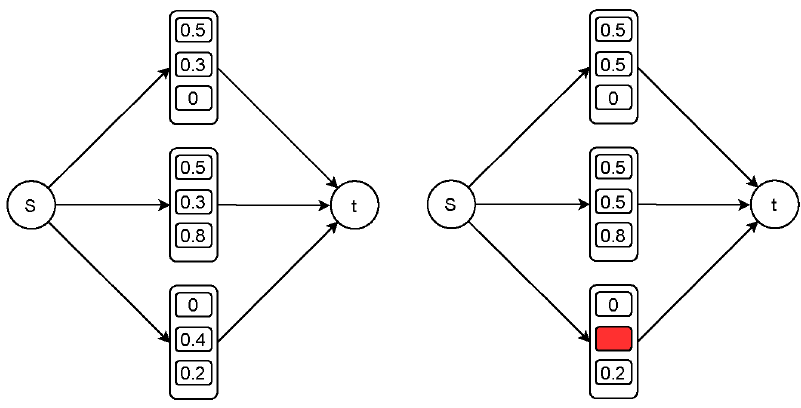
Figure 7. SFC failure correction.